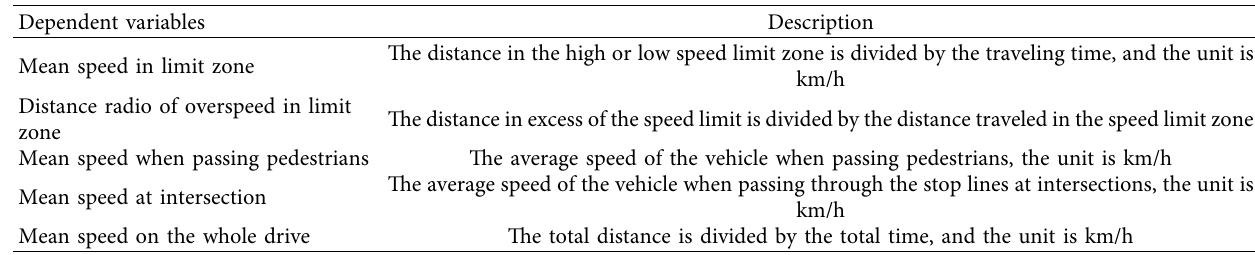
Table 3: Defnition of dependent